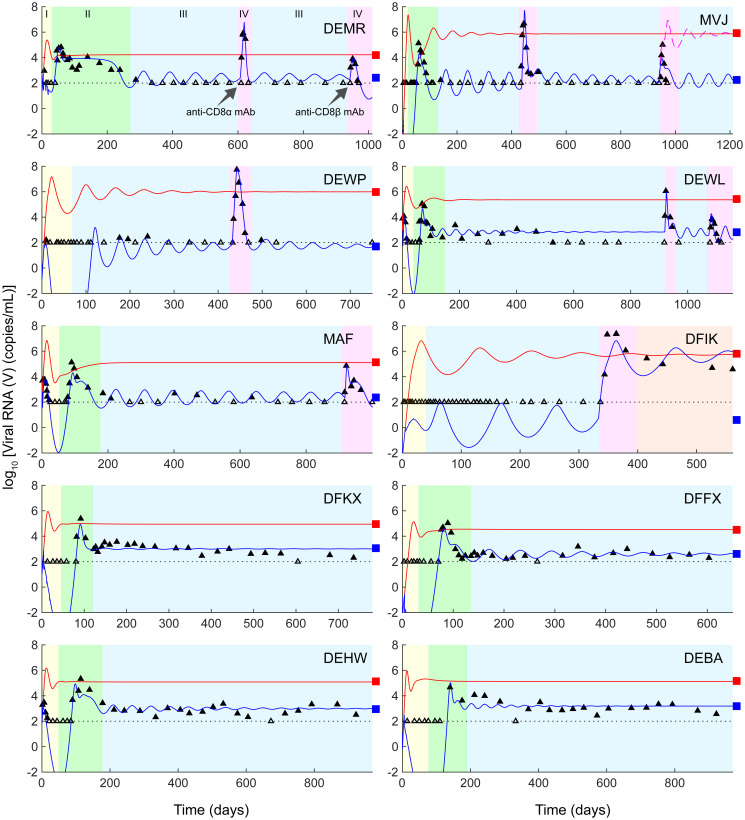
Model fits viral dynamics in responder macaques.Model fits (blue lines) to viral load data [10] (symbols) from the 10 controller macaques, shown in individual panels. Empty symbols mark measurements showing undetectable viremia and filled symbols above detection. The latter were used for fitting and the former censored. Black dotted lines in all panels indicate the viral load detection limit (100 RNA copies/mL). The corresponding bNAb concentration dynamics are in Fig 3. In all panels, phase I (yellow) marks the duration when bNAbs are present in circulation, phase II (green) the viremic resurgence post the clearance of bNAbs, phase III (blue) the ensuing viremic control, and, where relevant, phase IV (pink), in two parts, the disruption of this control using anti-CD8α and anti-CD8β Abs, respectively. For the macaque MVJ, we demonstrate the loss of viral control that occurs when effector depletion levels are increased (magenta dashed line), as is observed with the macaque DFIK. The digitized data used for the fitting is available as a supplementary excel file (S1 Data). In all cases, predictions without bNAb therapy are included for comparison (red lines). Parameter values used are in Table 1 and S1 Table. Macaques DEWP, MVJ, DFFX, DFKX, and DFIK were inoculated intrarectally and DEWL and MAF intravenously with 1000 TCID50 (50% tissue culture infective dose) of SHIVAD8-EO virus. DEMR, DEBA, and DEHW received 100 TCID50 intravenously. The treatments are summarized in S10 Table.